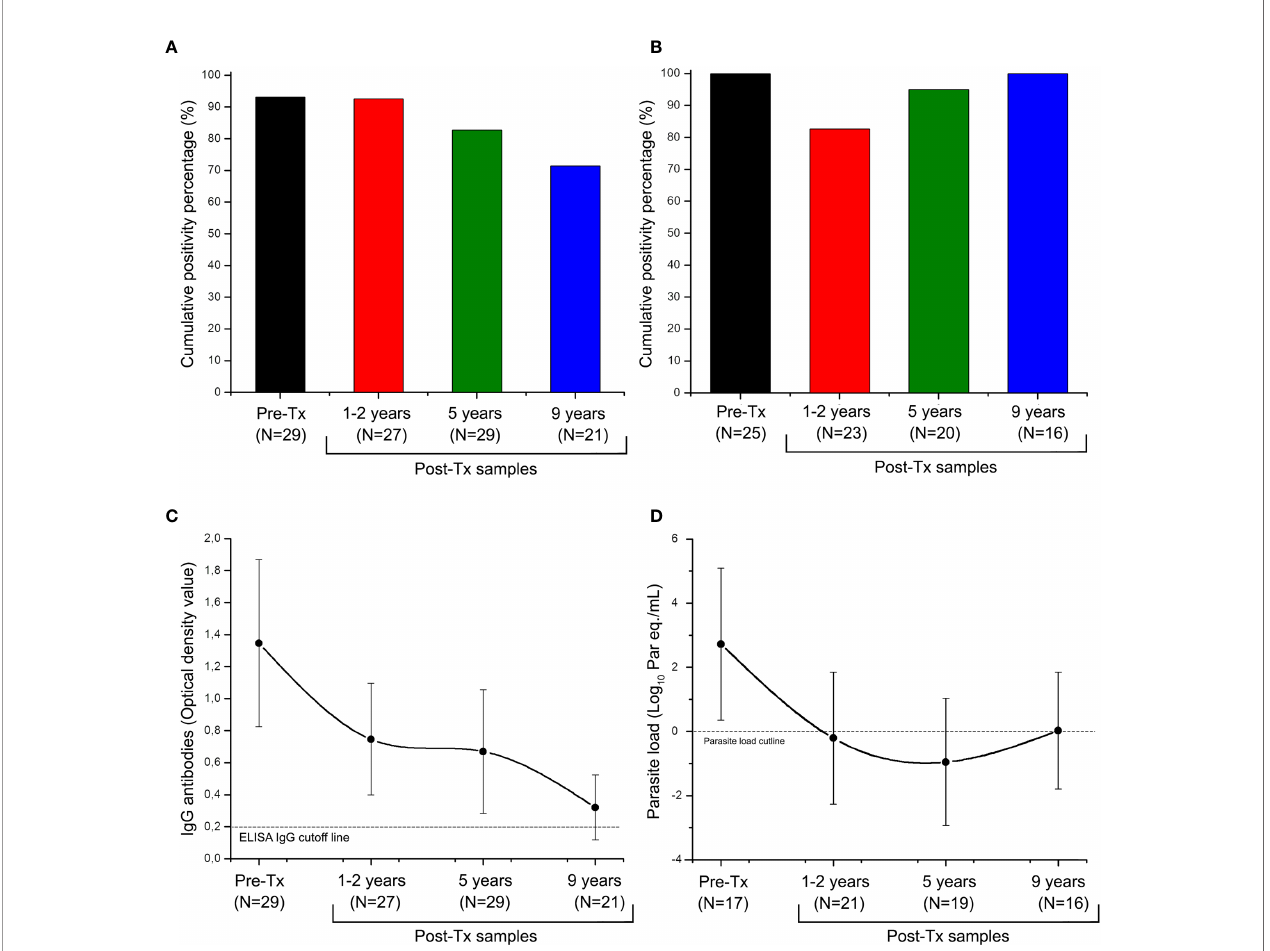
FIGURE 2 | Distribution of anti- Trypanosoma cruzi ELISA-IgG reactivity and SatDNA-qPCR positivity during the follow-up of patients of the Chichiriviche de la Costa oral Chagas disease outbreak. (A) Cumulative positivity percentage of ELISA-IgG; (B) satDNA-qPCR cumulative positivity percentage; (C) Trend of optical density values for the ELISA-IgG; (D) Trend of parasitic load values for the satDNA-qPCR. Tx: Treatment. ELISA IgG cutline: Optical Density (OD) value reportable by a positive sample (Diaz-Bello et al., 2008); TcI load cutline: 1 par eq./mL, lowest value of linear reportable range of qPCR (Duffy et al., 2013). The data in Figures (C) and (D) are presented as median and interquartile range from 25 to